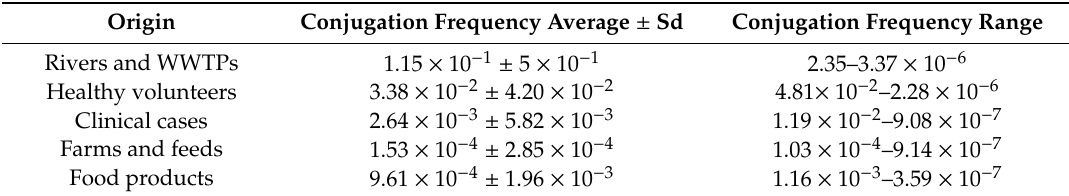
Table 4. Conjugation frequencies of ESBL-producing E. coli according to their origin.